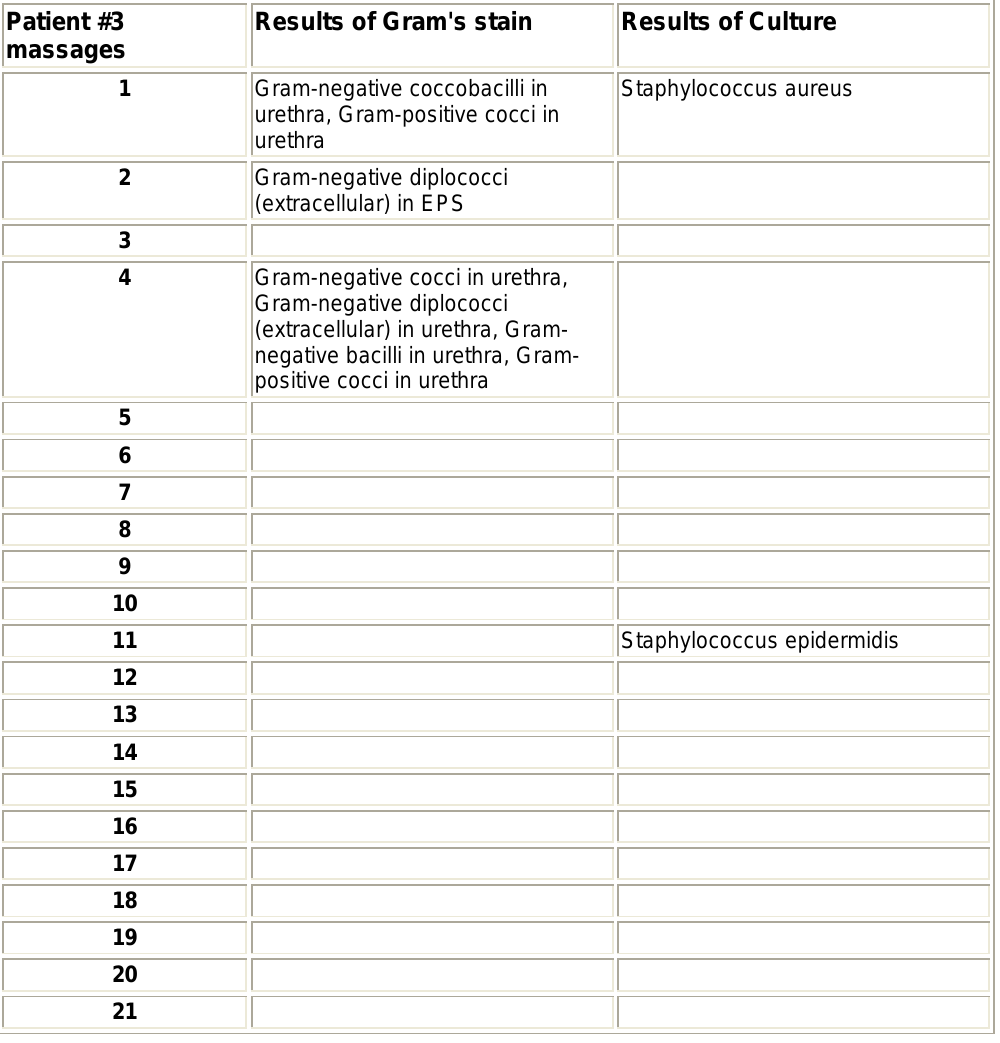
Results of Gram stains and cultures for patient